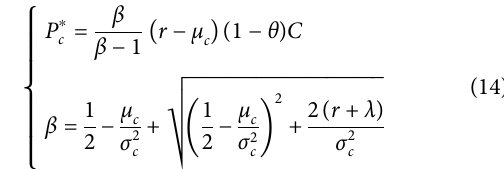
Frontiers in Energy Research |